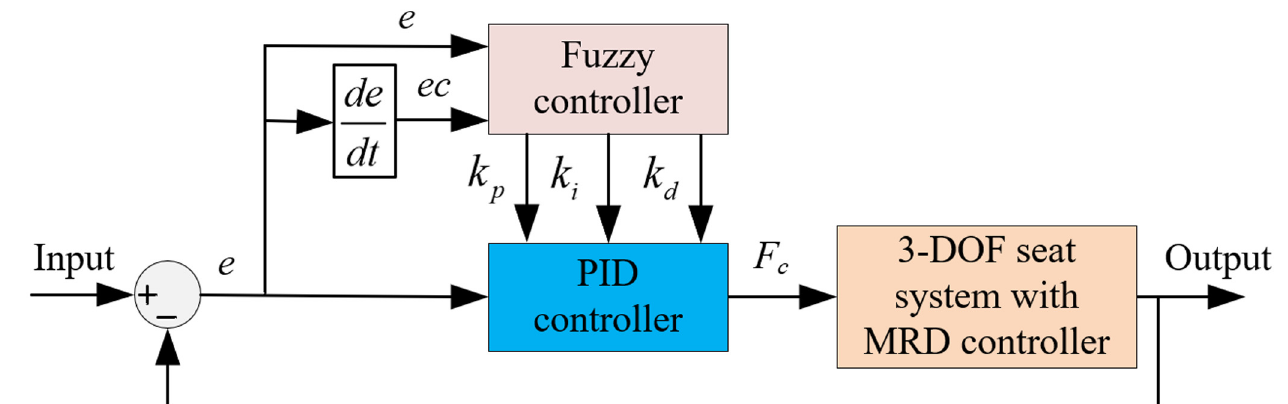
Fig. 7. Fuzzy-PID control